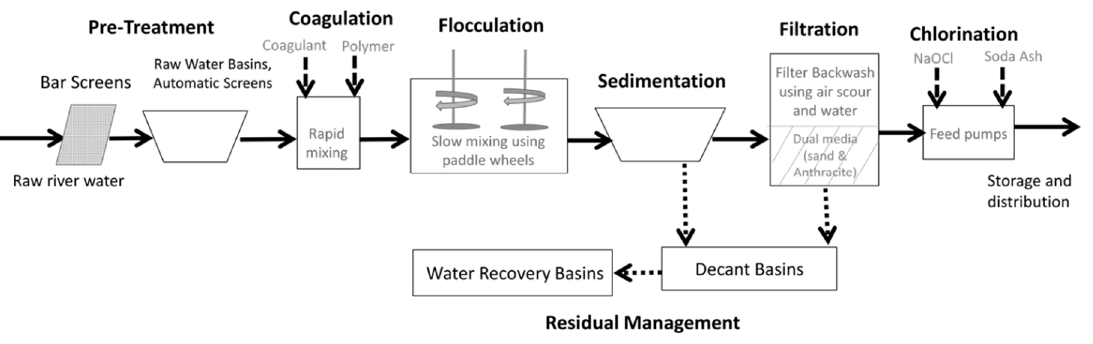
Figure 1. Process flow diagram for the selected drinking water treatment plant. Solid arrows determine the progression of water treatment, dashed arrows determine the chemical injection points, while dotted arrows determine the progression for residual management.